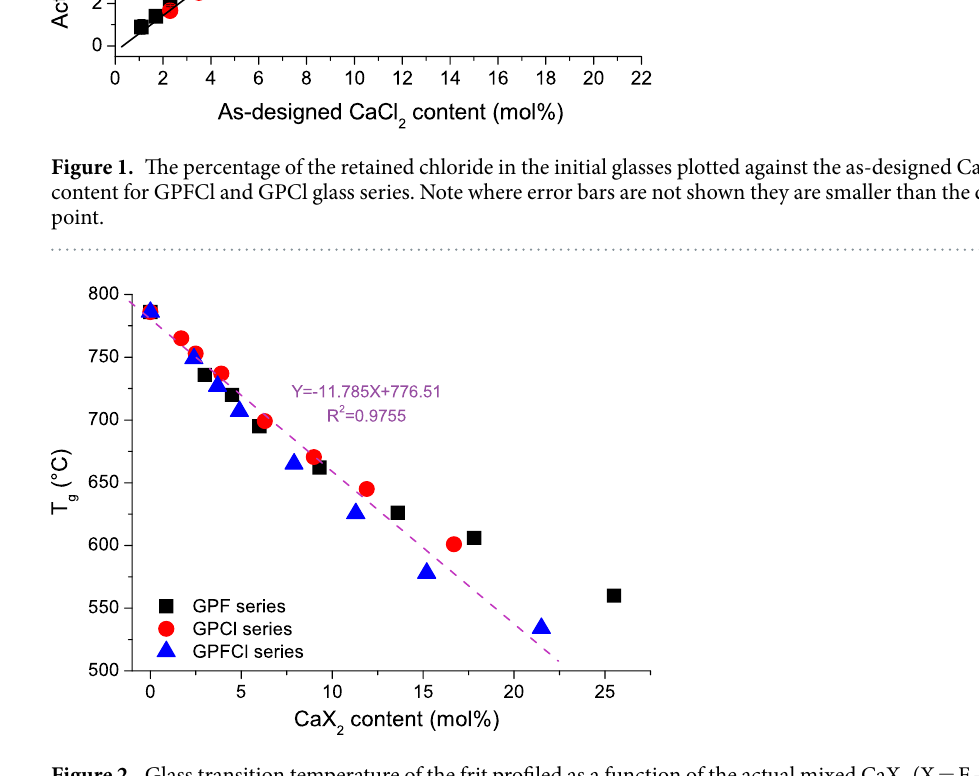
Figure 2. Glass transition temperature of the frit profiled as a function of the actual mixed CaX 2 (X = F + Cl) content. A linear relationship (Y = − 11.785x + 776.51, R 2 = 0.9755) between T g and CaX 2 content was shown in all three glass series with the exception of glass compositions GPF17.8 and GPF25.5, which are largely crystallised. The data for GPF and GPCl series previously reported 9,17 are shown here for a comparison